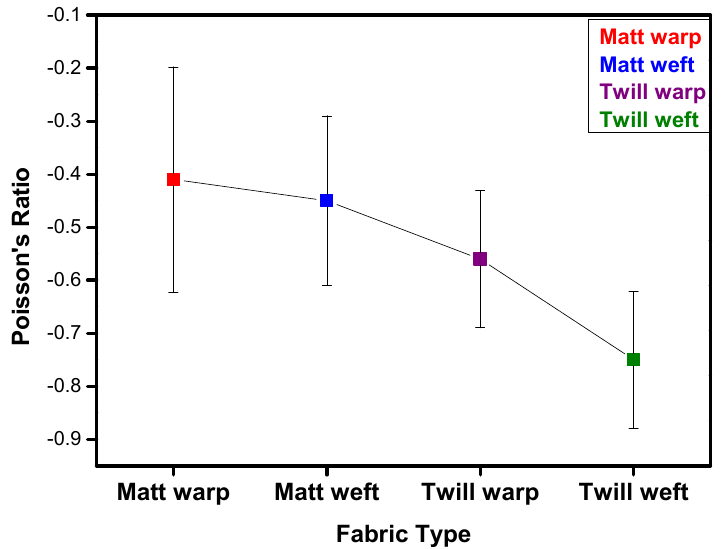
Figure 10. In-plane Auxetic effect for all fabric samples having Poisson’s ratio with error bars